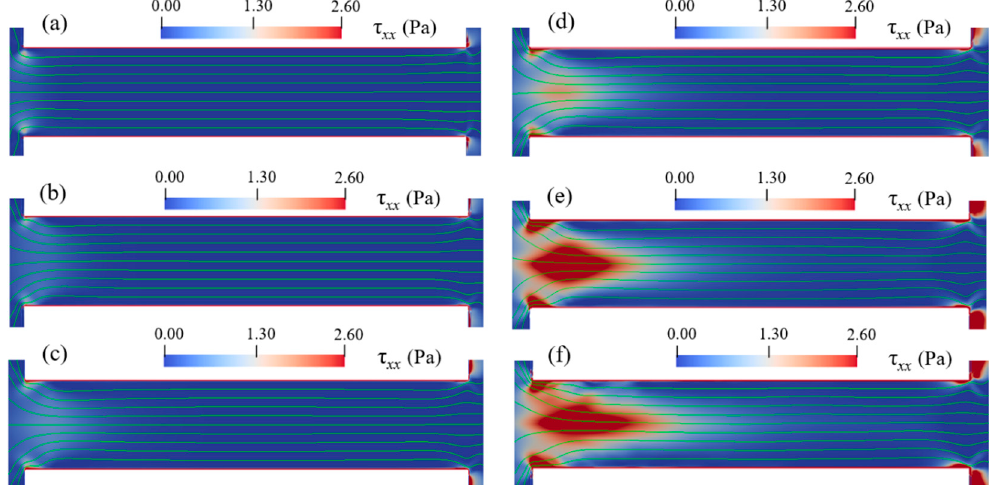
Figure 14. Streamlines in microchannel of 150 ppm PAA solution under different E app at 1.78 s: ( a ) 100 V/cm, ( b ) 200 V/cm. ( c ) 300 V/cm, ( d ) 400 V/cm, ( e ) 500 V/cm, and ( f ) 600 V/cm. The color bar represents the elastic normal stress τ xx